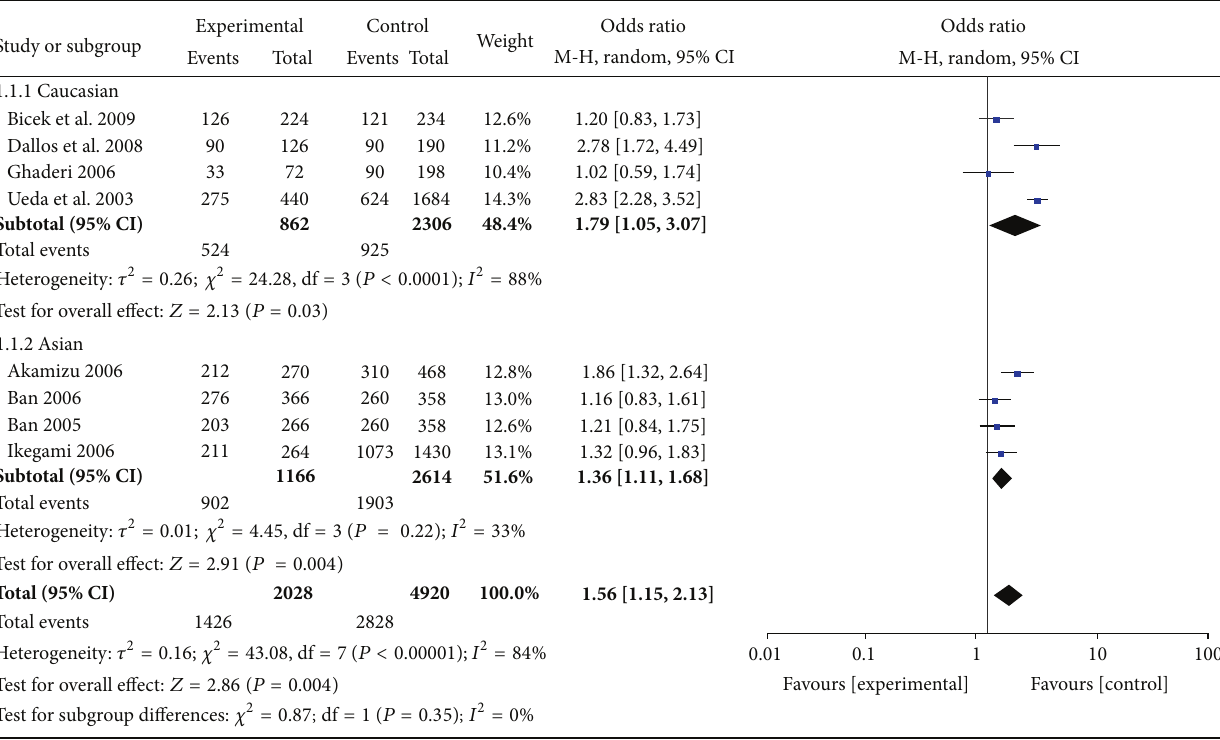
Figure 5: Forest plot of the association between an allele model of CT60 polymorphism and